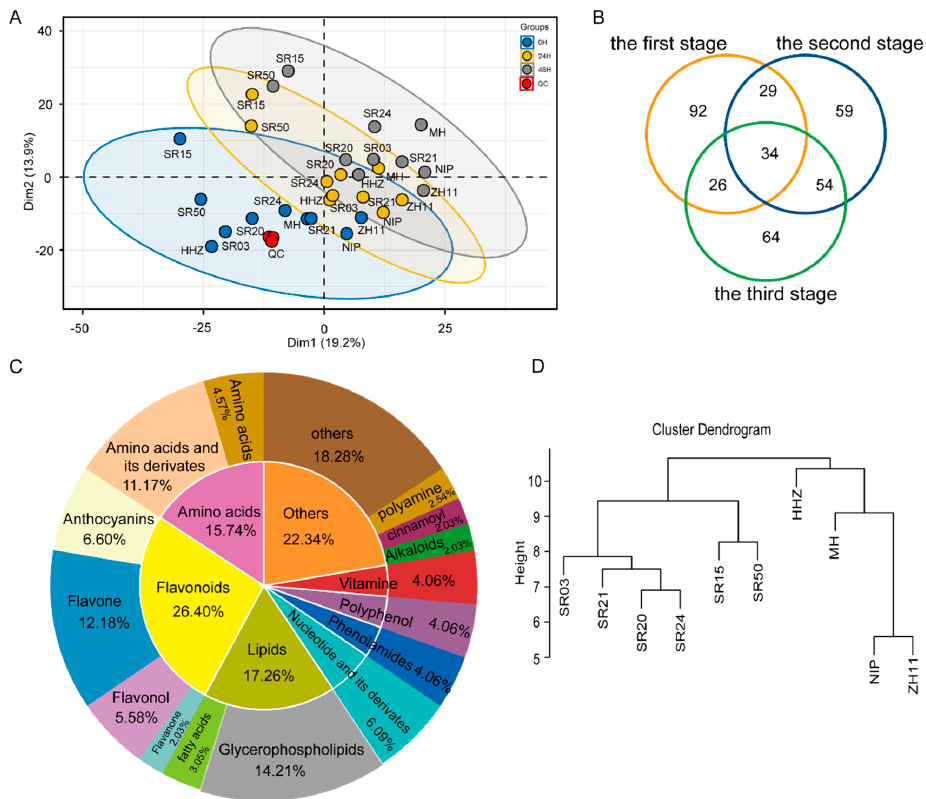
Figure 2. Comparative metabolic analysis in cultivar rice and landrace seeds during germination.